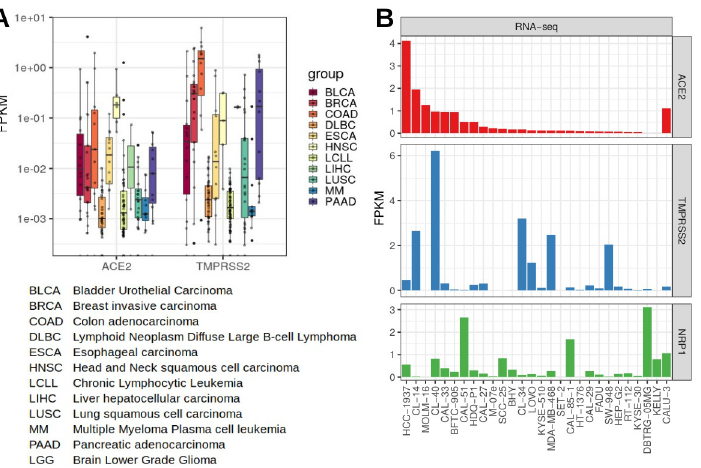
Fig 1. ACE2 and TMPRSS2 gene expression data for 301 DSMZ human cell lines in the CCLE RNA-seq data set. A: Expression of ACE2 and TMPRSS2 for selected disease entities. RNA-seq data were normalised and calculated to FPKM values. Gene expression for ACE2 and TMPRSS2 varies between and within the different tumour species. B: Expression of ACE2 , TMPRSS2 and NRP1 , cell lines sorted to ACE2 expression levels. Top 25 ACE2 expressing cell lines were selected for further studies, plus CALU-3 and two further neuronal cell lines with high NRP1 levels. FPKM—fragments per kilobase million: normalised gene expression data.